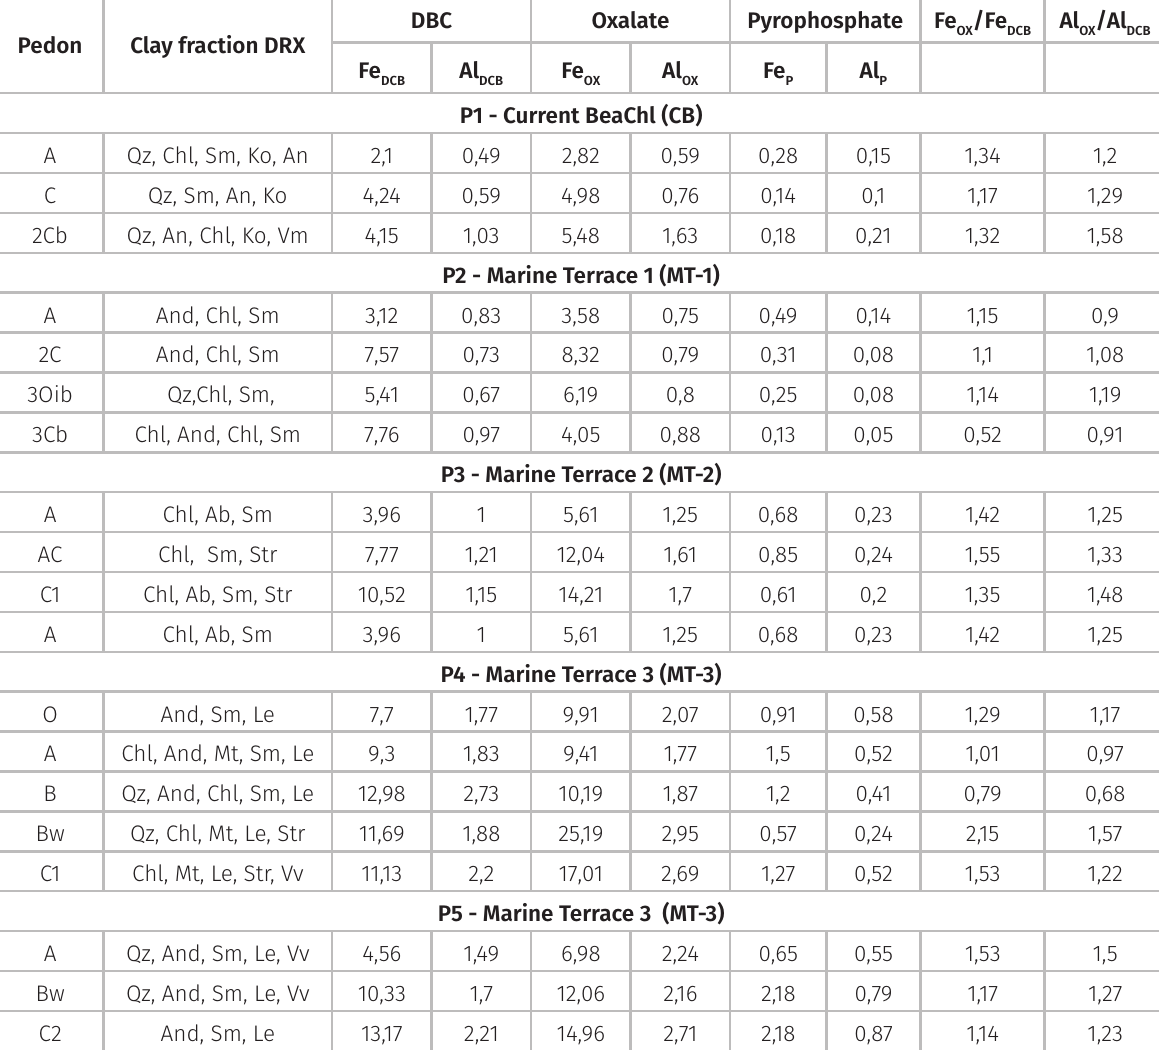
Table III. Mineralogy of clay fraction and Fe and Al (%) concentrations extracted by dithionite-citrate-bicarbonate, ammonium oxalate and pyrophosphate methods from the HP soils of marine terraces.